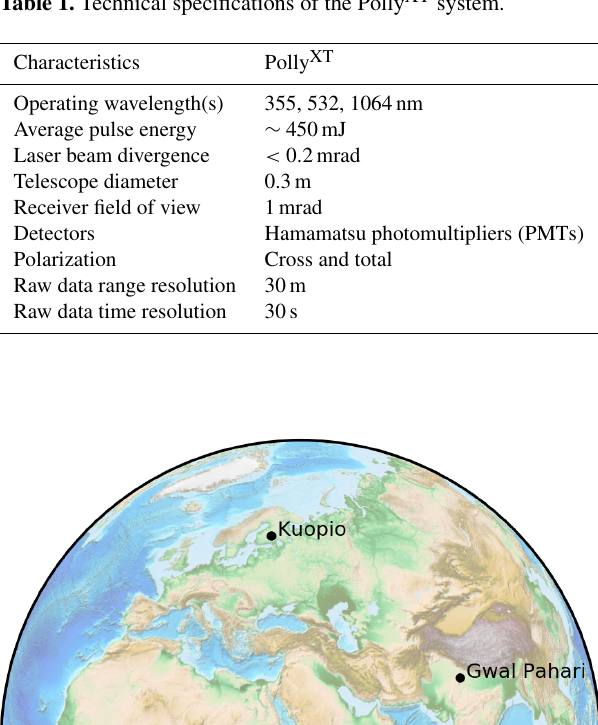
Table 1. Technical specifications of the Polly XT system.